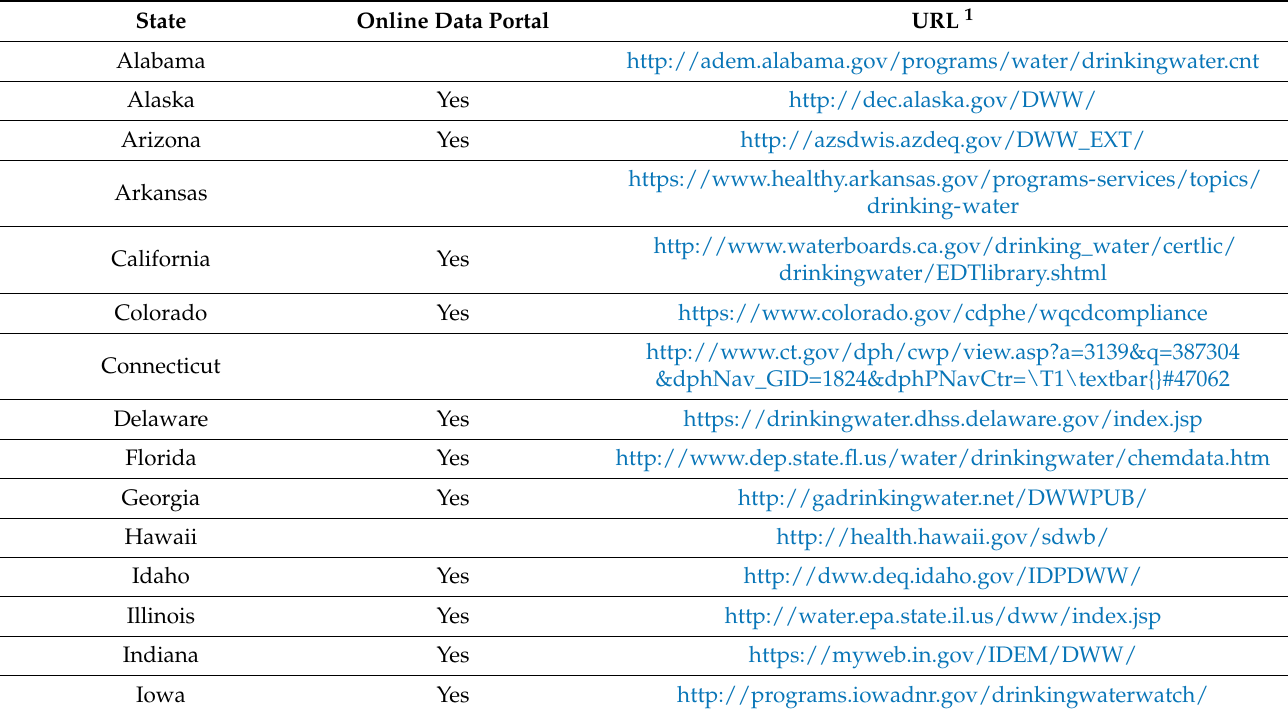
Table A1. Links for the websites of government agencies from which water quality data were obtained.